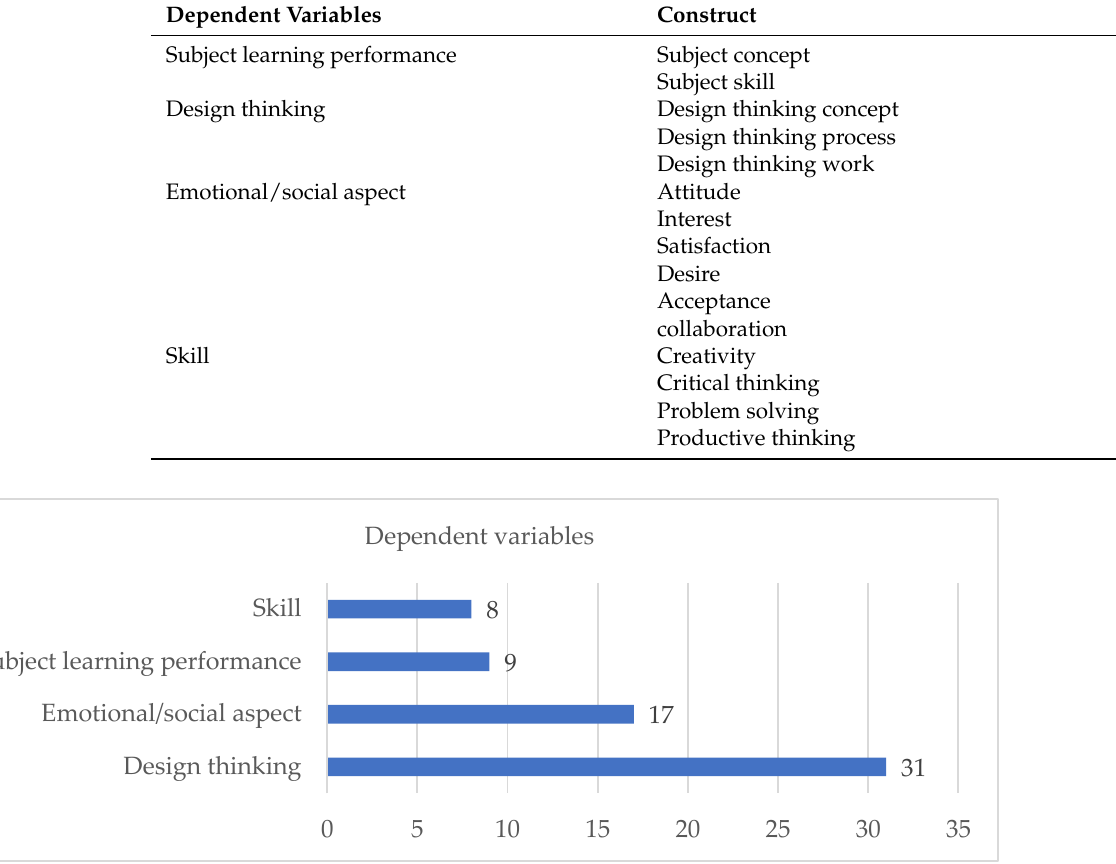
Figure 7. Dependent variables of the reviewed empirical studies.